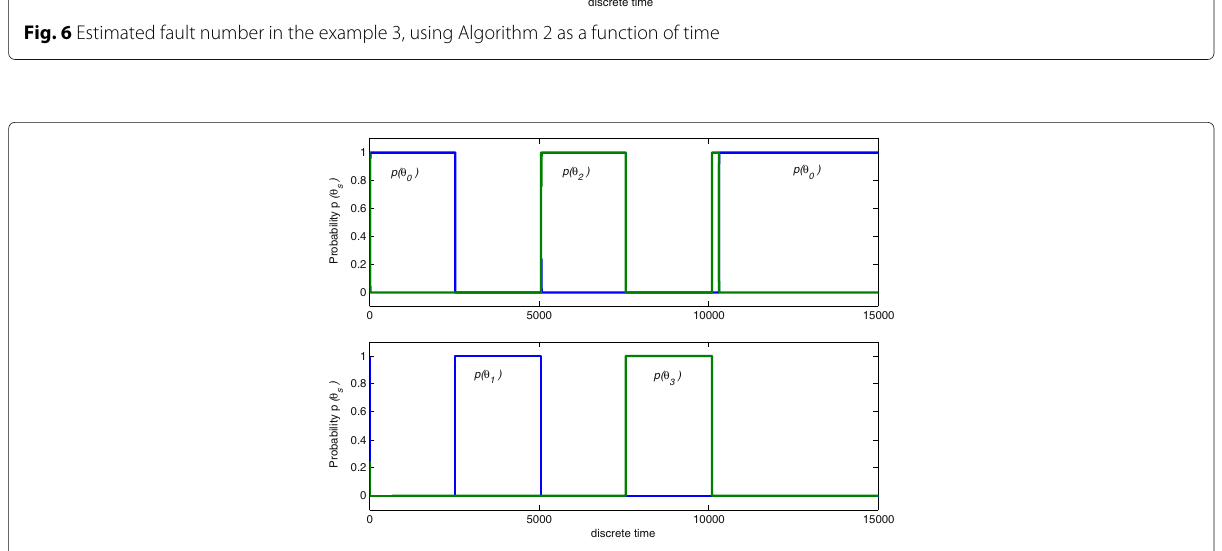
Fig. 7 Reconstructed probabilities of faults in example 3 estimated by the Algorithm 2